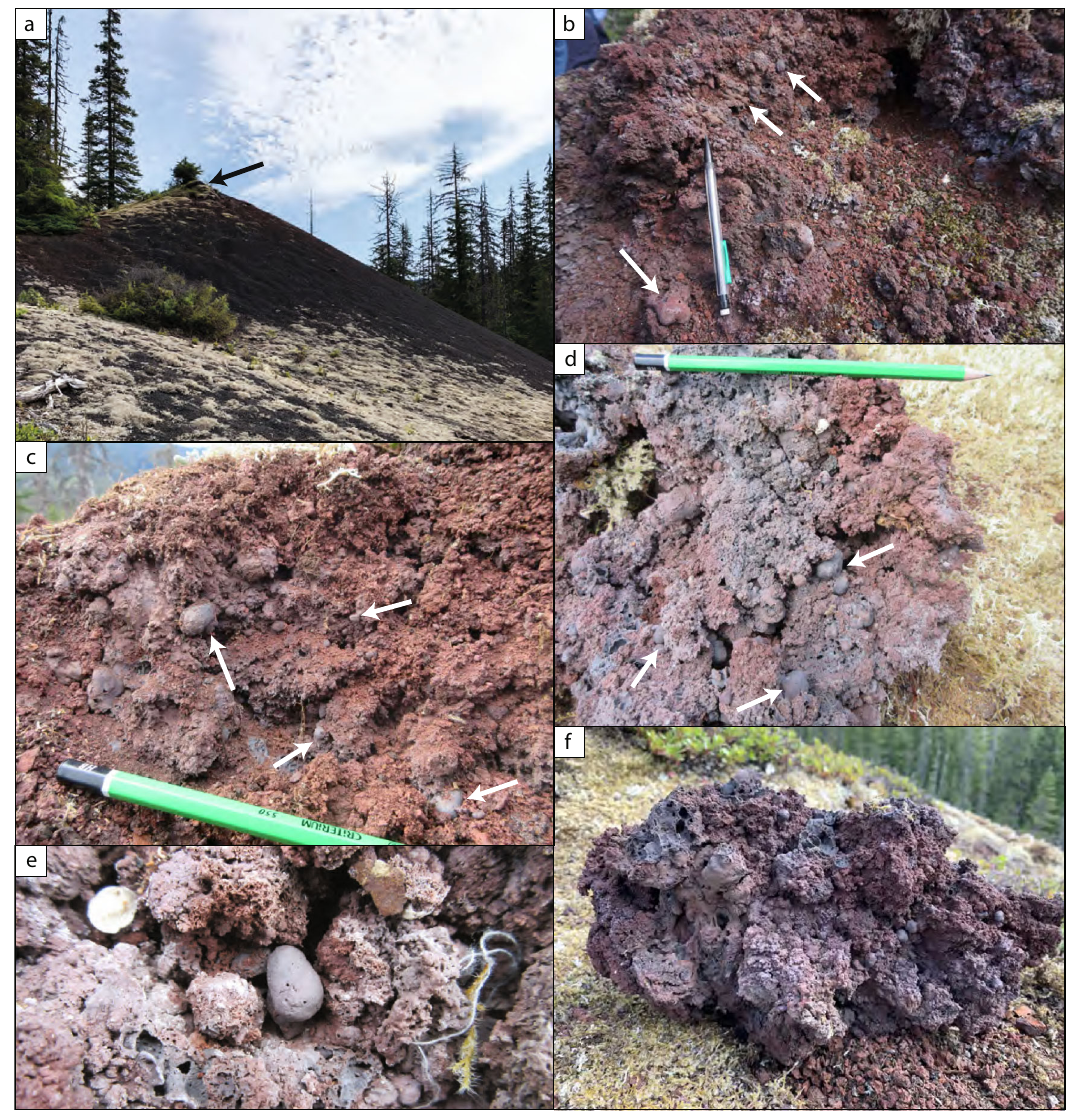
Fig. 2 Deposit scale observations of the Tseax Satellite cone. a Satellite scoria cone (height ~20 m) with in fl ated pyroclasts only found within ~5 m of the summit. The black arrow points to the location of the other fi gure panels. b – d Variably oxidised scoria cone deposits at the summit in the surface deposits. Some in fl ated pyroclasts are identi fi ed by the white arrows. These clasts have a smooth outer surface, a fl uidal morphology and are commonly rounded in shape. e Close up of an in fl ated pyroclast (~5 cm) surrounded by scoria. f Close up of a dissected block (30 cm in length) found at the summit of the Satellite cone which contains several in fl ated pyroclasts that are fl uidal in nature and in fi ll the space between scoria clasts. Further deposit photographs can be found in Fig.